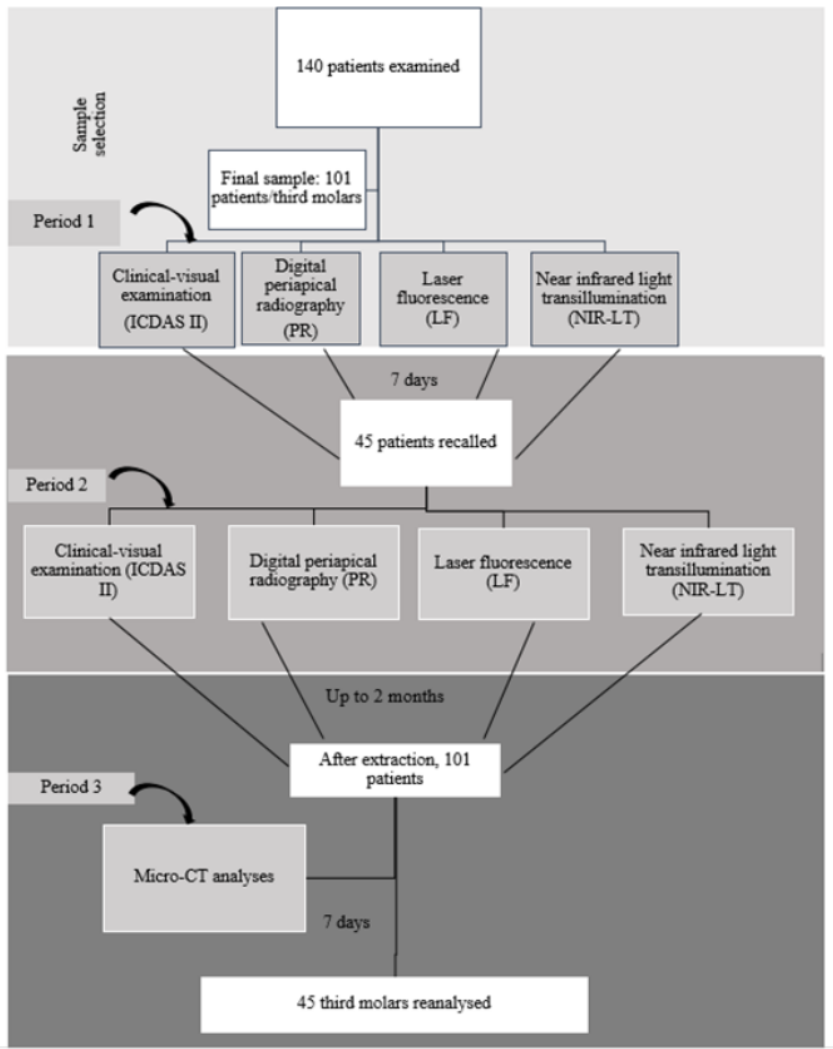
Figure 1. Study flowchart demonstrating the sequence of examinations performed in the study.